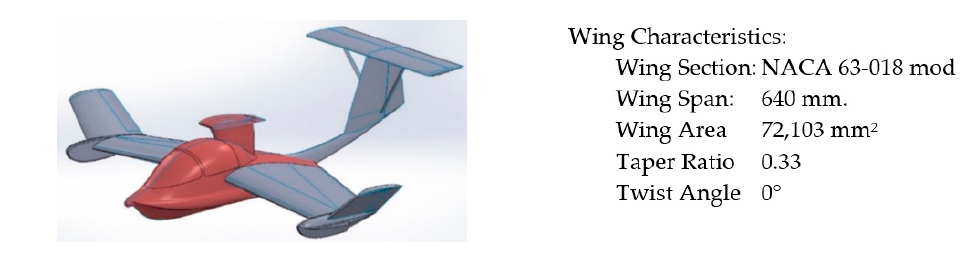
Figure 1. NEW1 WIG craft